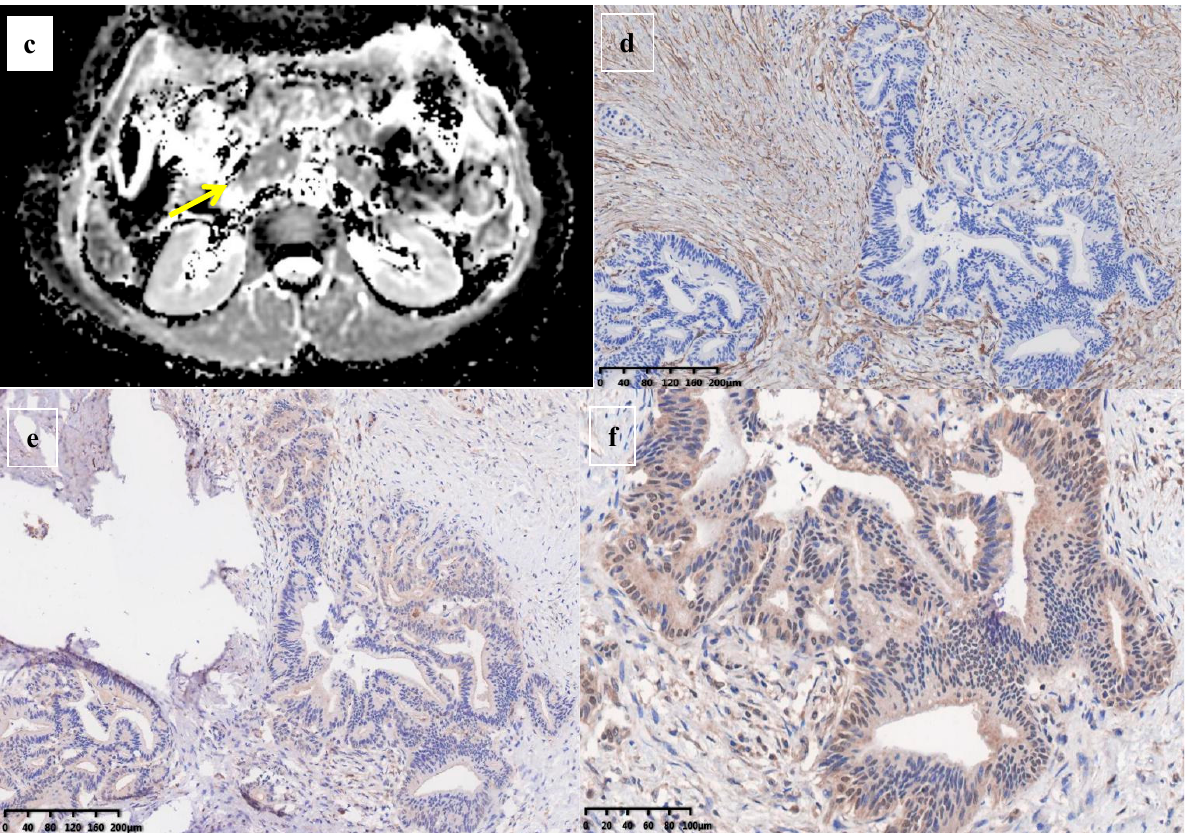
Figure 4. A 58-year-old woman was found to have a tumor with a head size of about 2.2 cm in the pancreas, which was pathologically confirmed to be pancreatic ductal adenocarcinoma after surgery; we found that the tumor was characterized by a high ADC value, high D value, and low f value after quantitative MRI measurement. She survived for 61 months without recurrence after surgery. MRI T2 ( a ); DWI ( b ); and ADC map ( c ) showed solid mass in the head of pancreas with measured ADC of 1.59 × 10 − 3 mm 2 /s, D value of 1.41 × 10 − 3 mm 2 /s, and f value of 0.18. Immunohistochemical staining showed that a few cancer-associated fibroblasts (CAFs) were present in the stroma (( d ) α -SMA, ×10), carcinoma cells weakly expressed VEGF in the cytoplasm (( e ) VEGF, ×10), and carcinoma cells showed weak immunoreaction of anti-HIF-1a in the nuclear(( f ) HIF-1 α , ×20). These findings suggested that the tumor microenvironment was relatively quiet with a lower hypoxia level.